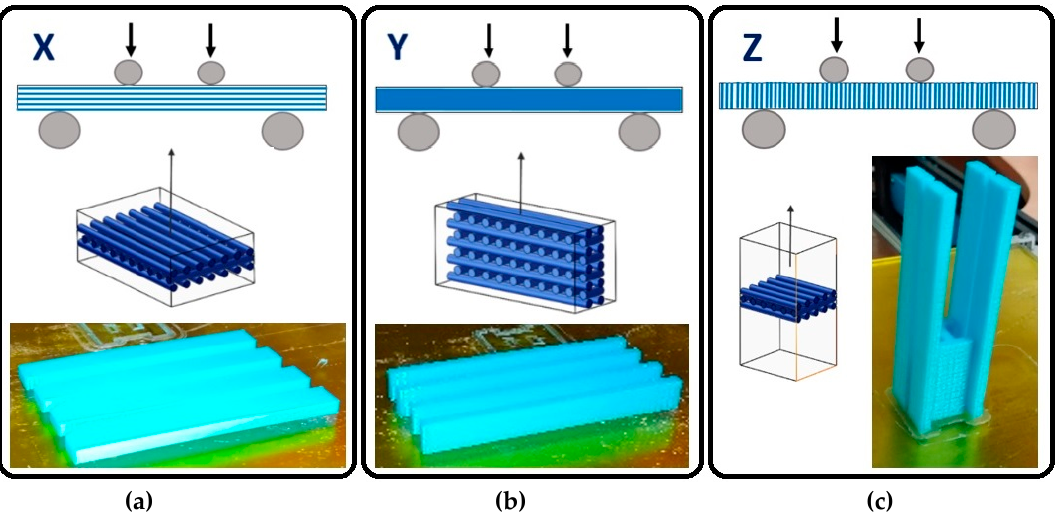
Figure 4. The orientation of the layers’ stacking, in the manufactured specimens. ( a ) X-axis oriented; ( b ) Y-axis oriented; ( c ) Z-axis oriented.